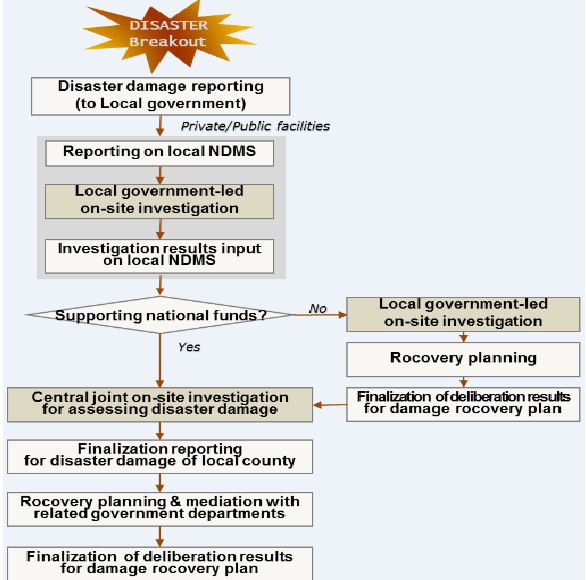
Figure 4. Disaster investigation procedures in Korea